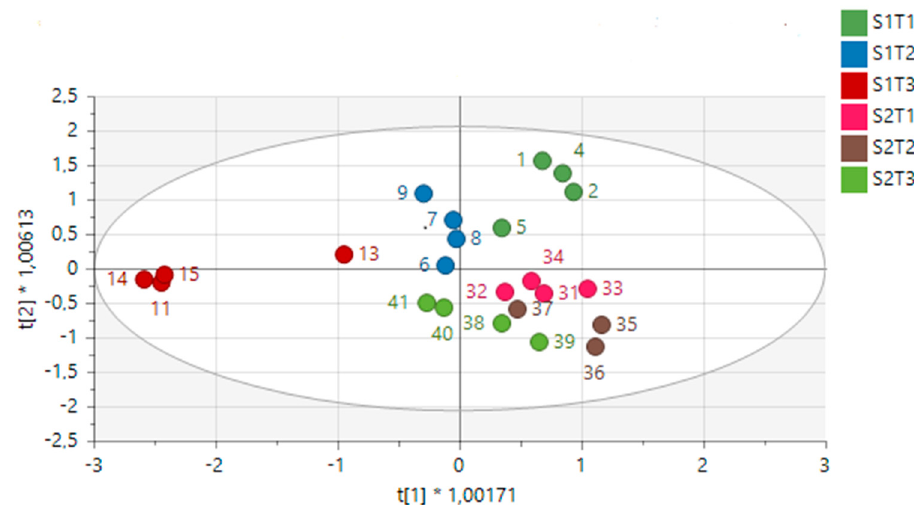
Figure 7. OPLS-DA score scatter plot of H. aureonitens leaf extracts collected from the wet and dry sites at Telperion during both spring and autumn seasons. R 2 X = 0.948, R 2 Y = 0.715 and Q 2 = 0.024. Green (S1T1) = spring site 1(wet); blue (S1T2) = spring site 2 (wet); red (S1T3) = spring site 3 (dry); pink (S2T1) = autumn site 1 (wet); brown (S2T2) = autumn site 2 (wet); olive (S2T3) = spring site 3 (dry).